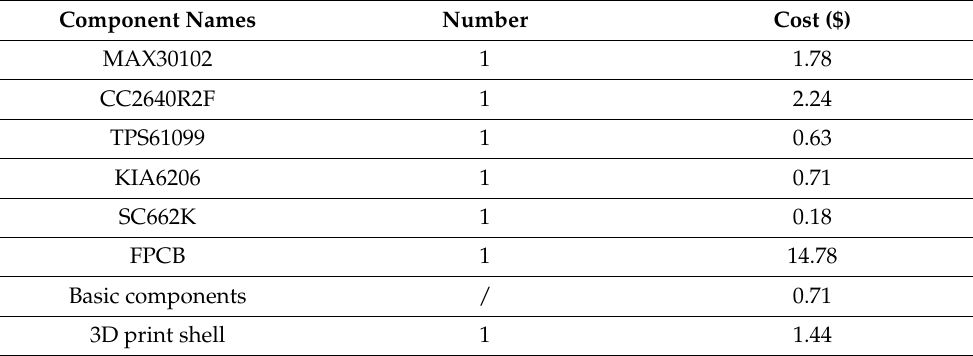
Table 5. Cost of device components (basic elements include resistors and capacitors,